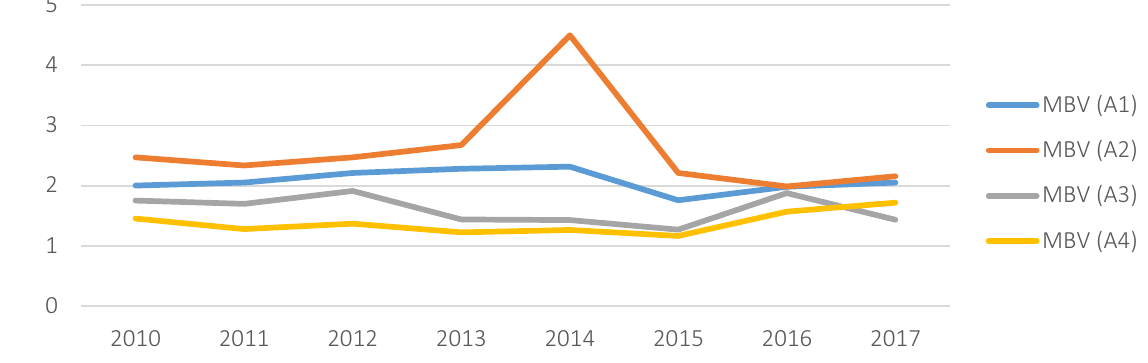
Figure 8. Comparison of mean of MBV between A1, A2, A3, and